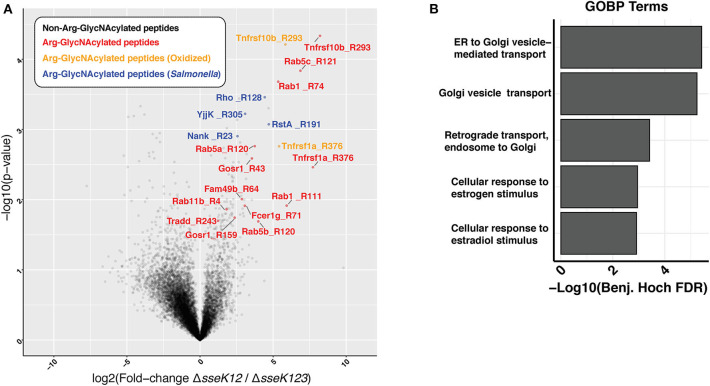
Enrichment of peptides Arg-GlcNAcylated by SseK3 derived from the insoluble fraction of Salmonella-infected RAW264.7 cell lysates. Arg-GlcNAcylated peptides were enriched and immunoprecipitated from the insoluble fraction of RAW264.7 cells infected with S. Typhimurium SL1344 ΔsseK12 or S. Typhimurium SL1344 ΔsseK123. (A) The volcano plot depicts the mean ion intensity peptide ratios of ΔsseK12 vs. ΔsseK123 plotted against the -logarithmic student t-test p-values from biological triplicate experiments. Arg-GlcNAcylated peptides with a fold change > 2 and a p < 0.05 are highlighted. Peptides are labeled by their gene names followed by the location of the Arg-GlcNacylated arginine. Arg-GlcNAcylated peptides from the host cell are highlighted in red; Methionine oxidized Arg-GlcNAcylated peptides from host cell are highlighted in yellow; Arg-GlcNAcylated peptides from Salmonella are highlighted in blue. (B) Bar chart of enrichment analysis of GO-terms (Biological processes) associated with Arg-GlcNAcylated peptides compared to all observed peptides from immunoprecipitation experiments. Fisher's exact enrichment analysis demonstrates the over-representation of Golgi-associated processes with Arg-GlcNAcylated proteins in the insoluble membrane immunoprecipitation.